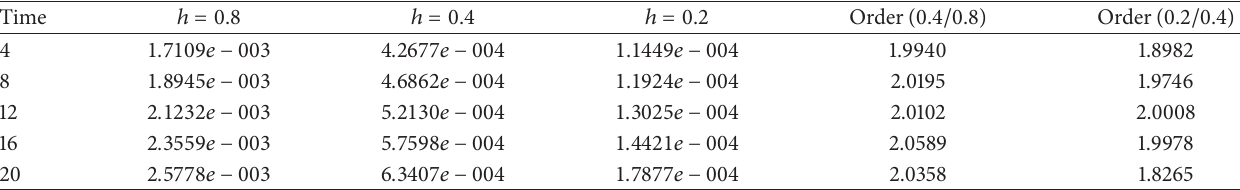
Table 6: Convergence order and error in 𝐿 2 norm for 𝑢 of space with Δ𝑡 = 0.01 and 𝑐 = 0.1 . Time ℎ =